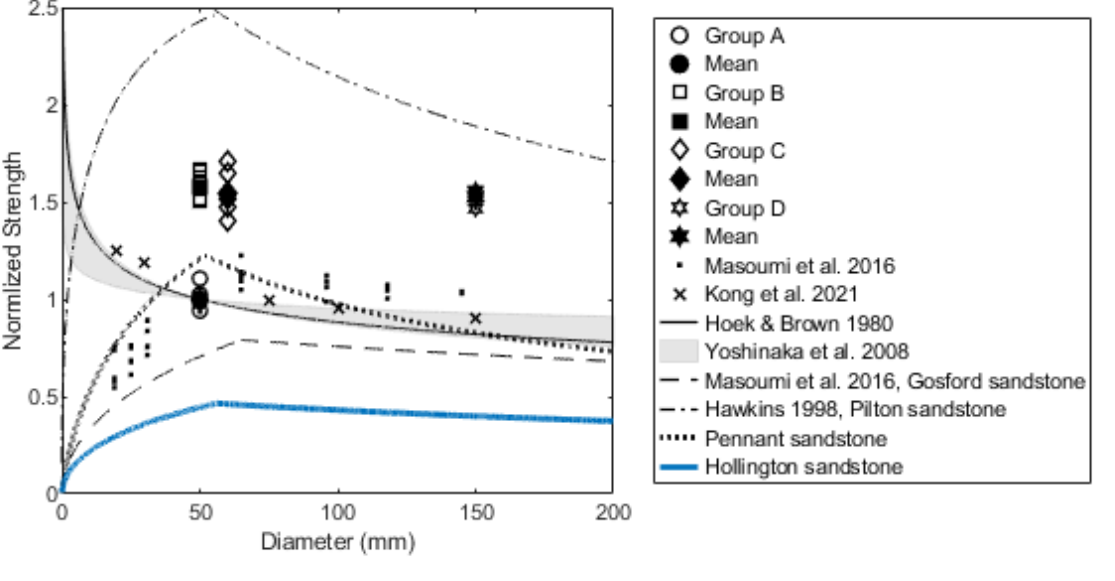
Figure 14. Size effect on diameter.